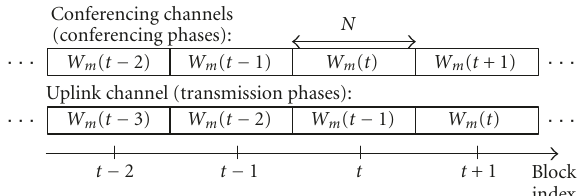
Figure 2: Frame structure for transmission on the conferencing and uplink channels. The transmission phase of messages { W m ( t ) } M occurs at slot t + 1 after the corresponding conferencing